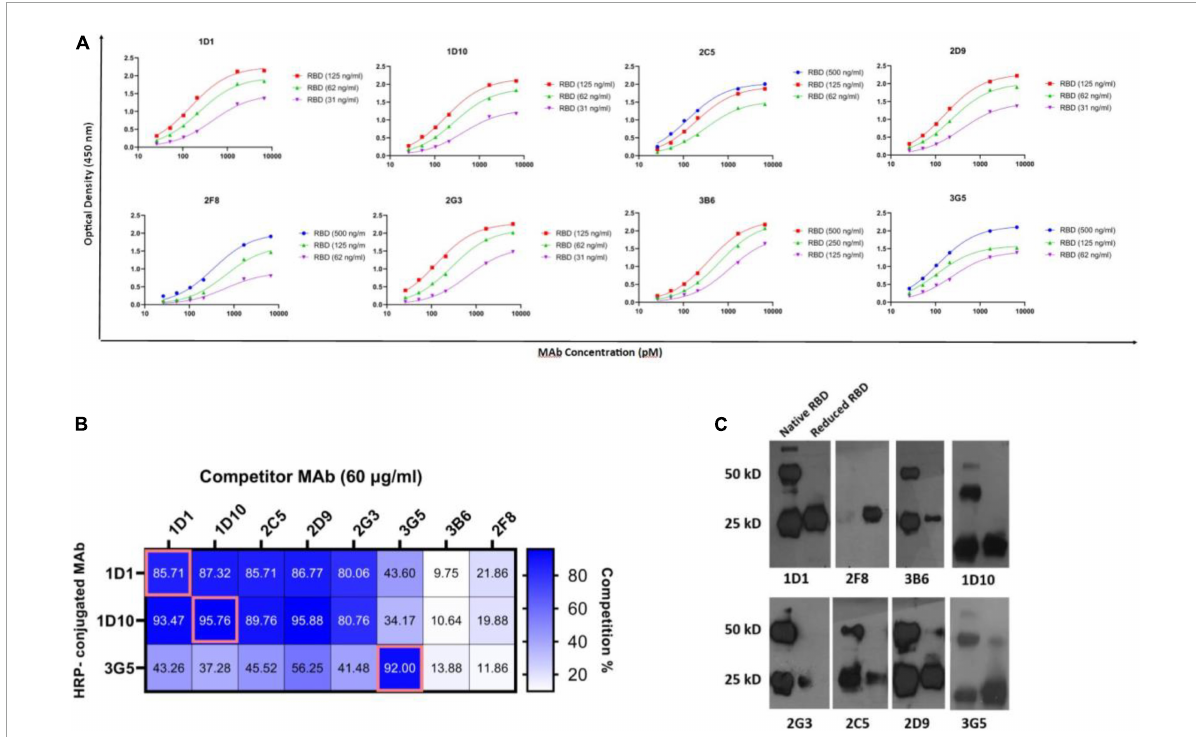
FIGURE4 Binding affinity, competition profile, and structural characterization of anti-RBD MAbs. (A) The binding affinity of MAbs to RBD protein was measured by an ELISA-based method. MAbs concentration at OD 50% was used to calculate affinity constants (Ka) between each pair of sigmoidal curves in the graphs based on the equations referred to in section “Materials and methods.” The final Ka was obtained by averaging three calculated Ka. (B) The competition profile of MAbs was determined by competitive ELISA. Results of competition ELISA are presented as the percentage of competition by the competitor MAbs compared with no-competitor groups. Competition for more than 50% was considered as positive. (C) Western blot representative of reactivity of selected double-reactive MAbs against 2ME-reduced and native RBD proteins. A total of 25 and 50 kD bands show monomeric and dimeric RBD protein. Ag, antigen; ELISA, enzyme-linked immunosorbent assay; HRP, horse-radish peroxidase; MAb, monoclonal antibody; nM, nanomolar; OD, optical density; pM, picomolar; RBD, receptor binding